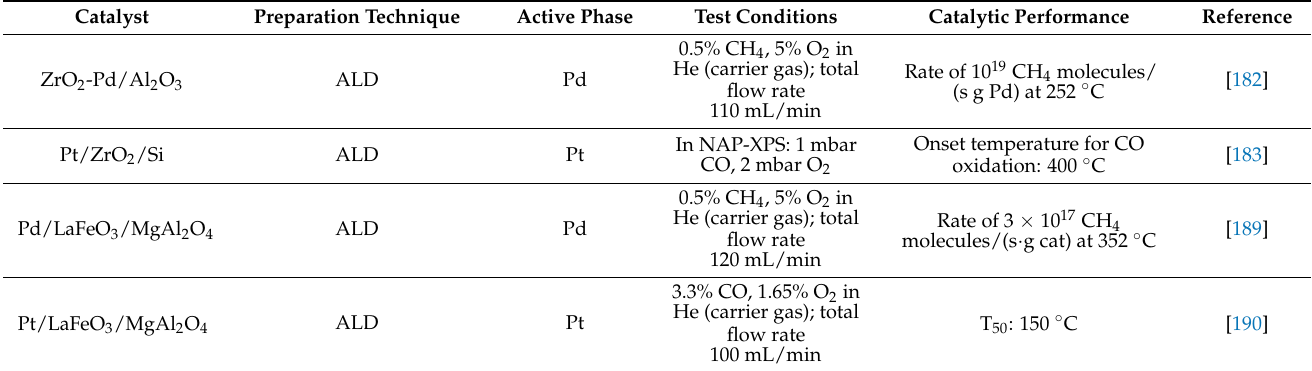
Table 2. Previous results of thin films used in noble metal catalysts for combustion